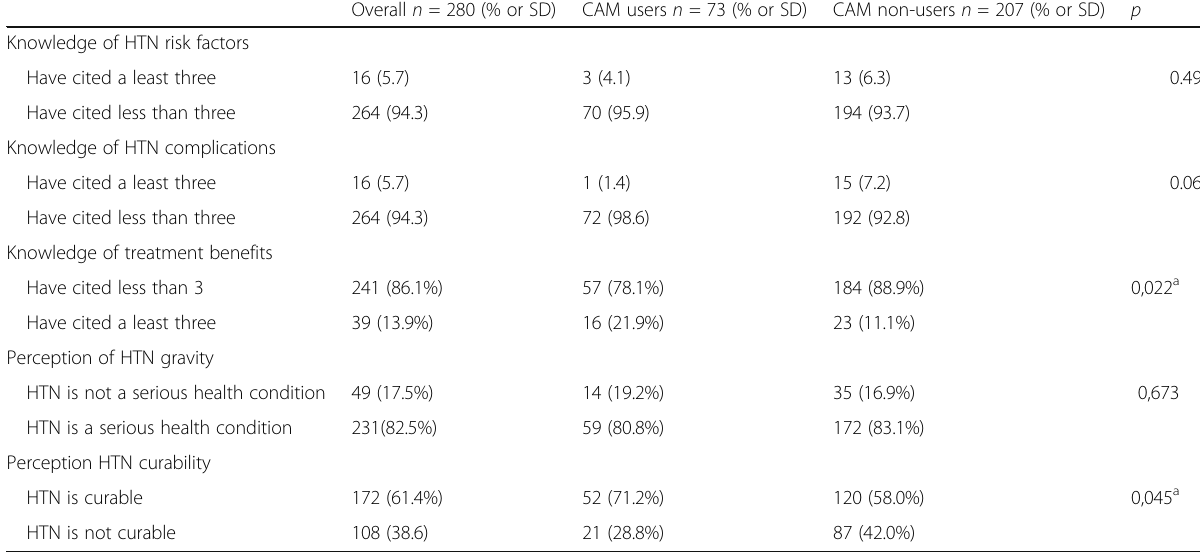
Table 6 Use of CAM,knowledge and perception of